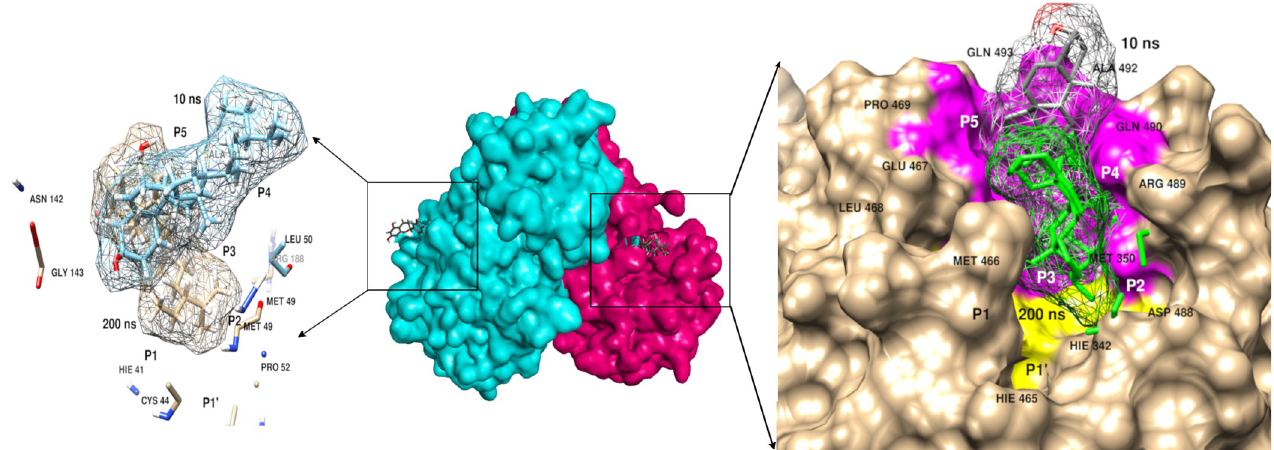
Fig 6. MD simulations of beta-sitosterol exhibited strong electrostatic interactions and stable conformational dynamics with both the chains of dimer 3CL pro .